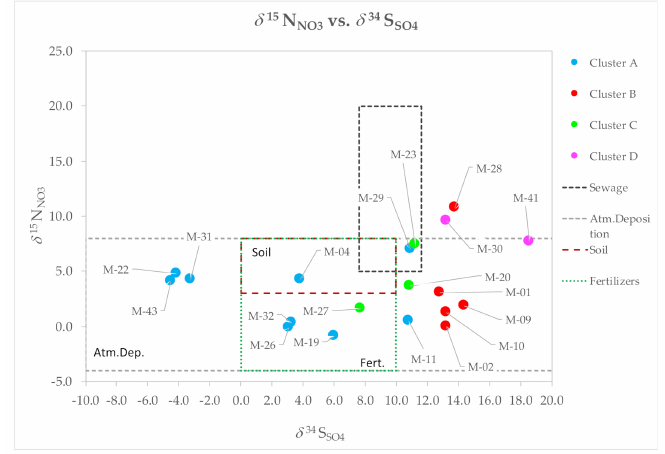
Figure A7. Dual-isotope diagram δ 15 N NO3 versus δ 34 S SO4 representing the isotopic composition boxes of atmospheric deposition, soil, fertilizers, and sewage with the water samples collected in the study area with both data available (in total 19